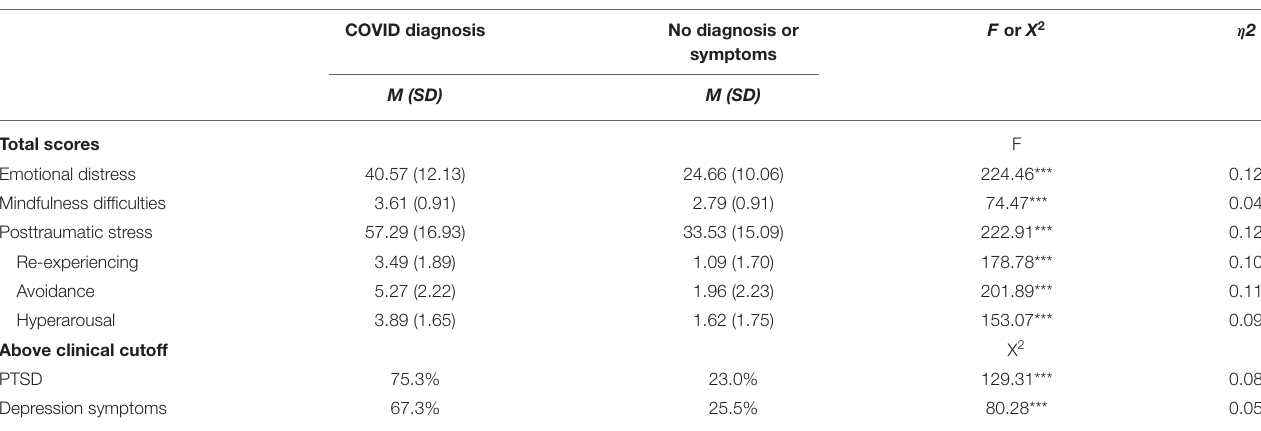
TABLE 3 | Current mental health by COVID diagnosis